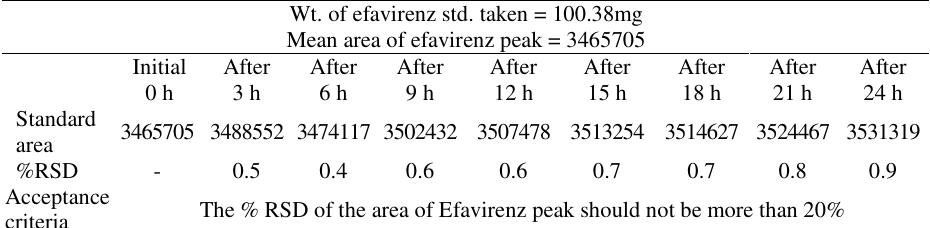
Table 6. Stability of solution data for developed method Wt. of efavirenz std. taken =